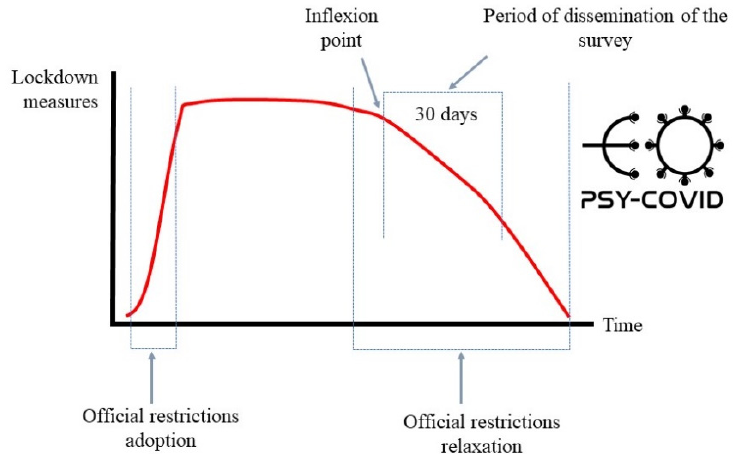
Figure 1. Selection of the time of dissemination of the survey.